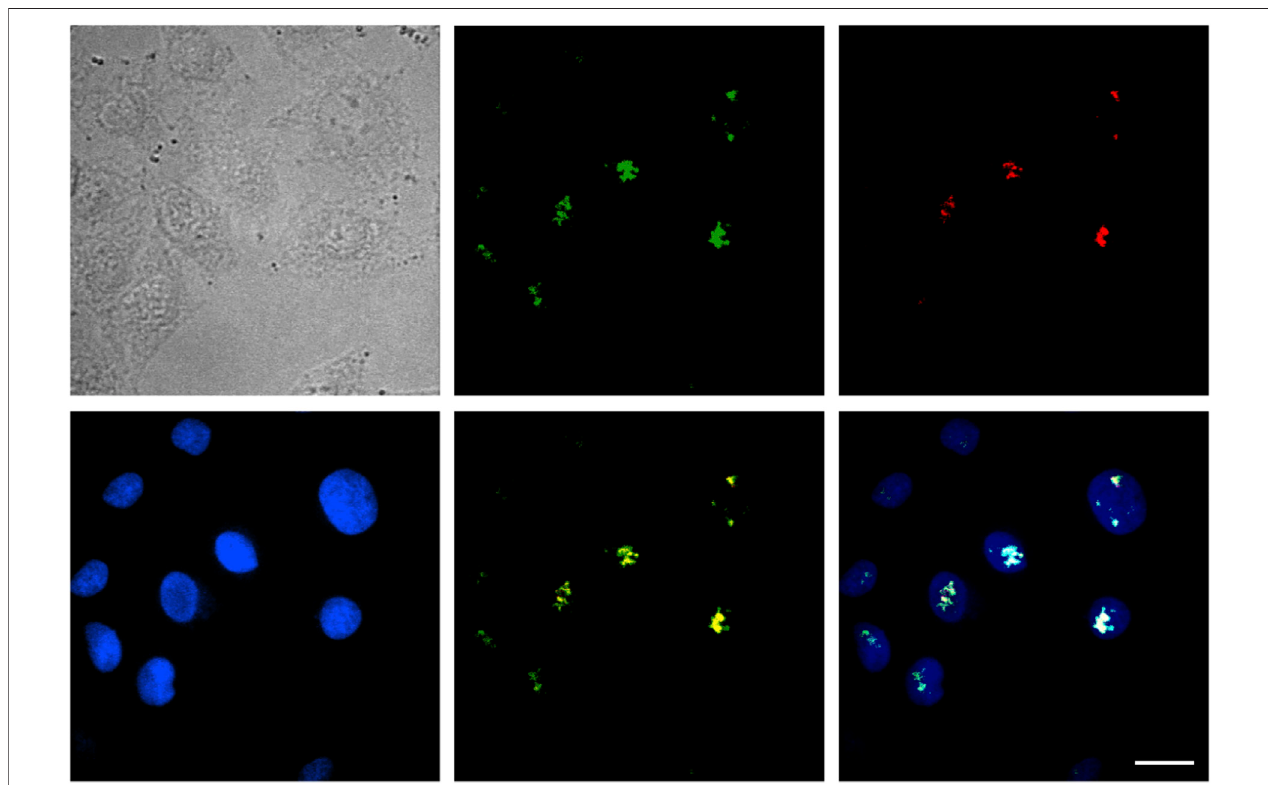
FIGURE 4 | Intranuclear fate of SDots-Tat. The top left image is a bright- fi eld image of cells. The top middle image is for SDots-Tat (green fl uorescence). The top rightimageisfortheB23proteinlocatedinthenucleolus(red fl uorescence).Thebottomleftimageisforthecellnucleus(labeledbyHoechst33342,2 μ g/ml).Thebottom middle image is an overlay of SDot-Tat and B23 protein. The bottom right image is an overlay of SDot, B23 protein, and nucleus. Scale bar, 20 μ